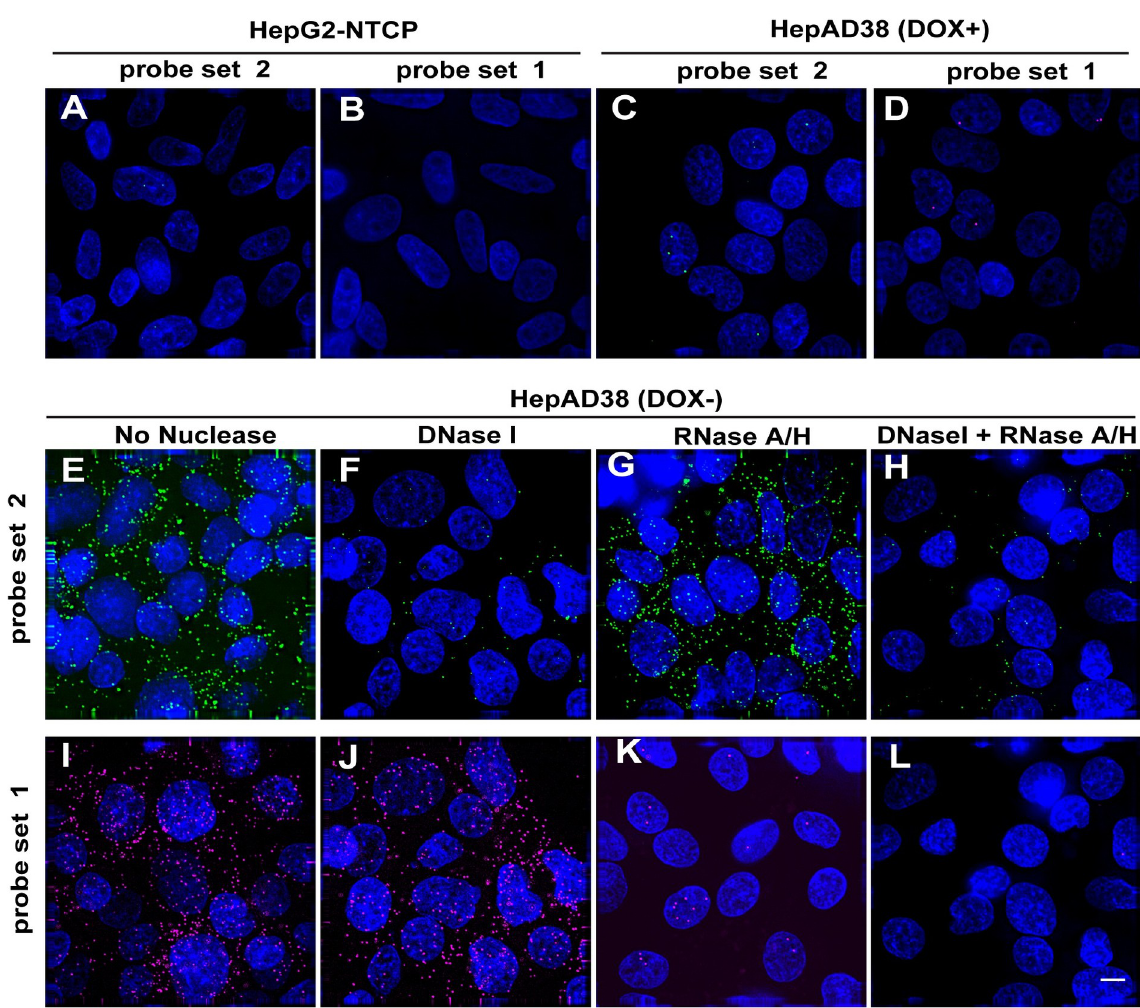
Fig 1. HBV RNA and DNA detection with specific probe in HepAD38 (DOX) cells. HepG2-NTCP (A-B) and HepAD38 (DOX-) cells (E-L) were maintained in the doxycycline-free medium, HepAD38 (DOX+) cells (C-D) were maintained in the doxycycline medium for 7 days, then cells were fixed and stained. Prior to probe labeling, cells were treated with buffer alone (A-D, E, I), DNase I (F, J), RNase A/H (G, K), or DNase I + RNase A/H (H, L). Probe set 2 was used for HBV (-) DNA (green); Probe set 1 was used for HBV (+) DNA and pgRNA (purple). These two probe sets were mixed and hybridized with cells and signals were captured in two independent channels (Probe set 2 Cy5, Probe set 1 Cy3), representative images were shown. Scale bar, 4 μ m.